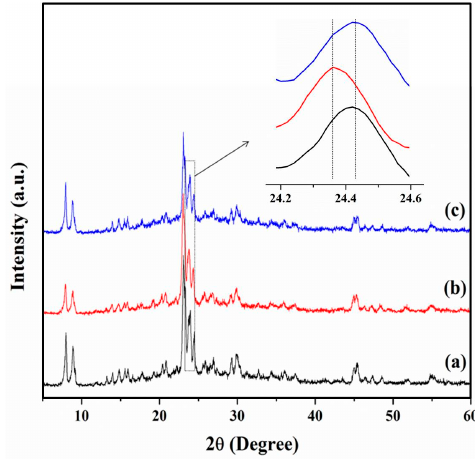
Figure 6. XRD patterns of H-Z-30 before and after IL-treatments. ( a ) H-Z-30; ( b ) IL-treated H-Z-30; and ( c ) samples of calcined IL-treated H-Z-30 at 823 K for 5 h.